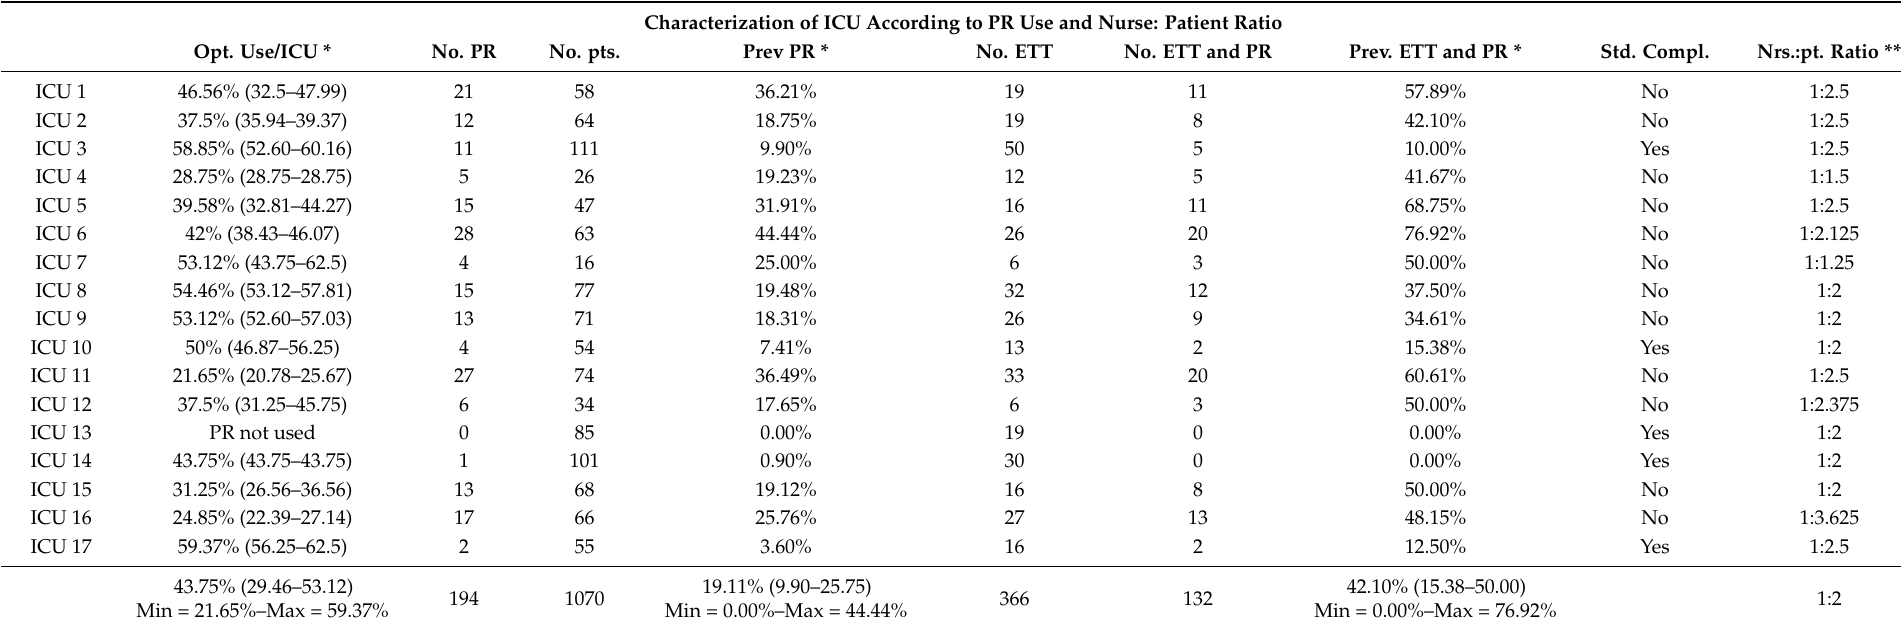
Table 7. Characterization of intensive care units according to approximation to optimal physical restraint use, prevalence of physical restraints, prevalence of physical restraints in intubated patients, compliance with standard of prevalence of restraints, and nurse:patient